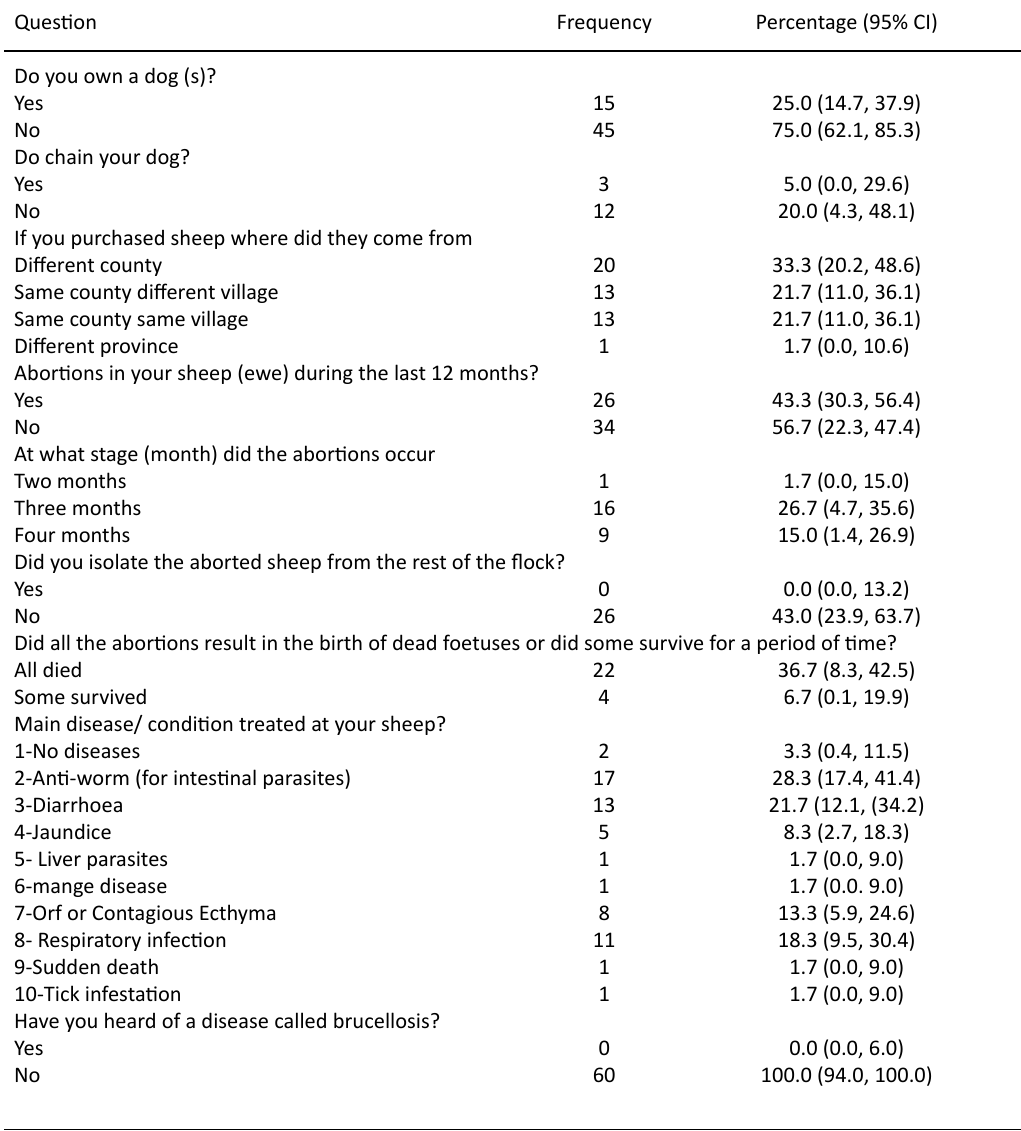
Table 5. Descriptive analysis of ten variables at the level of farm in Basrah